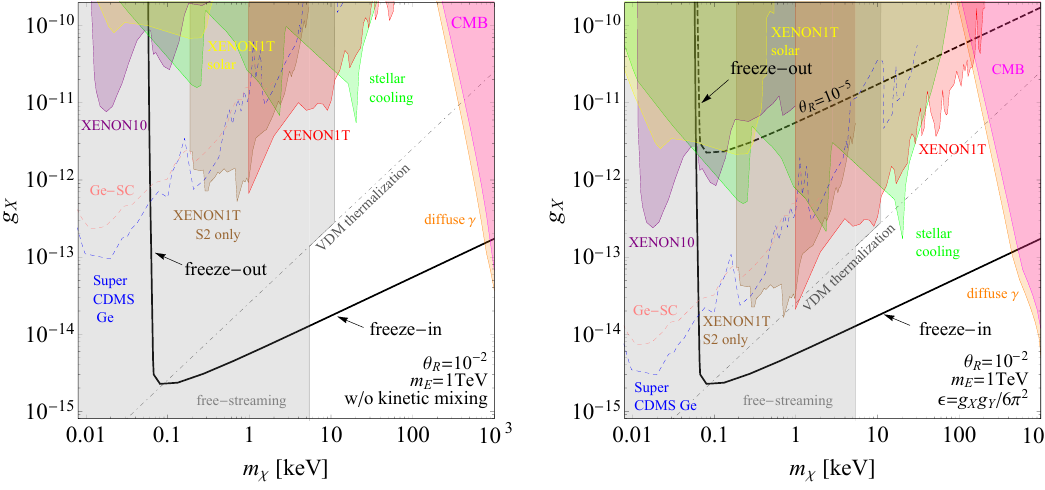
Figure 3 . Constraints on VDM, χ µ , in the m χ − g X plane for m E = 1 TeV , θ R = 10 − 2 and (cid:15) = 0 (left) or (cid:15) = g X g Y / 6 π 2 (right). The solid black line denotes the Ω χ h 2 = 0 . 12 contour above (below) which VDM is over (under) abundant. Above the dot-dashed line VDM is in chemical equilibrium with the thermal bath and produced by freeze-out while relativistic; below, VDM is produced by freeze-in through E → χe decay. Shaded areas show regions excluded by searches of VDM absorption in direct detection experiments, including recast [25] from XENON10 [52] (purple) and XENON1T with electronic recoil data [53] (red) or ionisation signals (S2) only [54] (brown), solar emission (yellow), stellar cooling constraints [25], CMB anisotropies [55] (magenta), diffuse γ - ray background observations [56] following ref. [25] (orange) and structure formation (gray). Dashed lines denote projected sensitivities from future direct detection experiments like SuperCDMS, with Ge target [57] (blue), and using Ge semiconductor target [26]